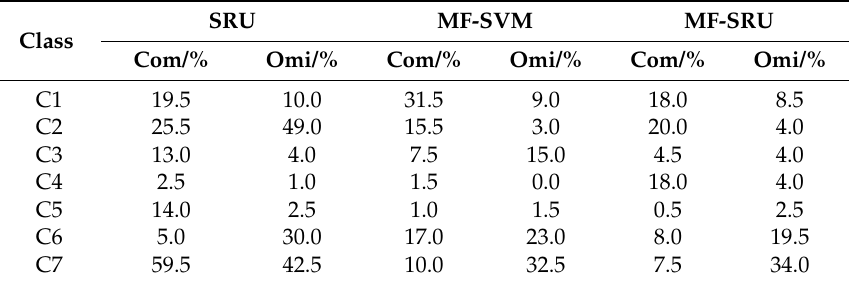
Table 4. Comparison of commission and omission